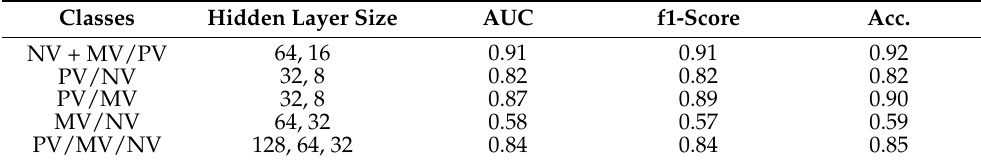
Table 10. EV classification